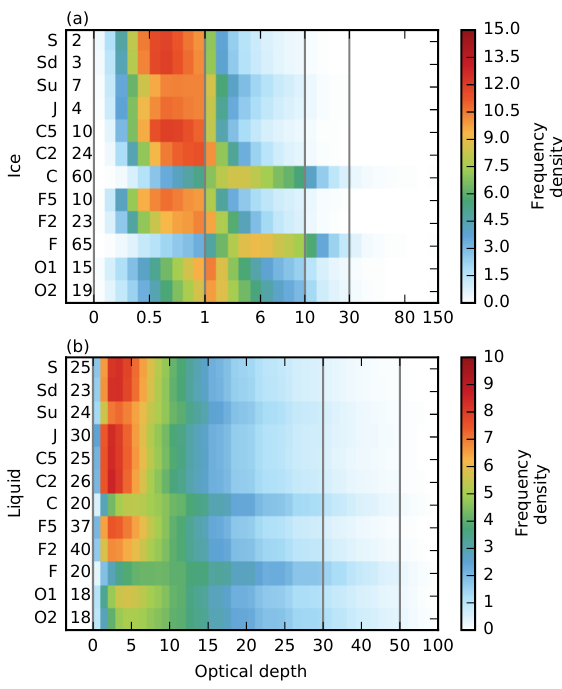
Figure 6. The mean normalised MODIS collection 6 cloud optical depth distribution for each of the regimes, showing clouds classi- fied as (a) ice phase and (b) liquid phase separately. The bins are taken from the MODIS level 3 daily product, vertical lines indicate a change in bin width. The frequency density is normalised by the bin width and sums to 1 within each regime. The numbers along the right-hand edge of each plot show the percentage occurrence of valid retrievals within that regime (analogous to a cloud fraction). Note the different scale for the two plots.